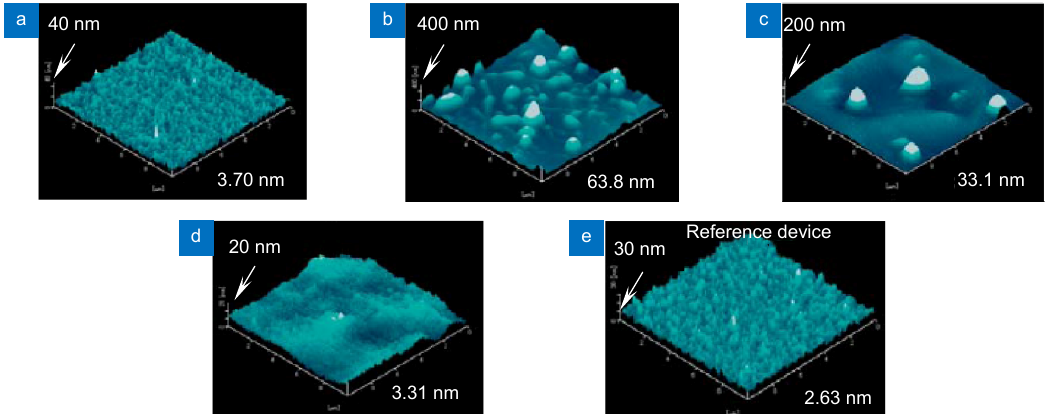
Fig. 6 | AFM image of the P3HT: PCBM layer. Acetone concentrations 45 . (a) 5, (b) 10, (c) 15, and (d) 20 vol%. (e) Reference